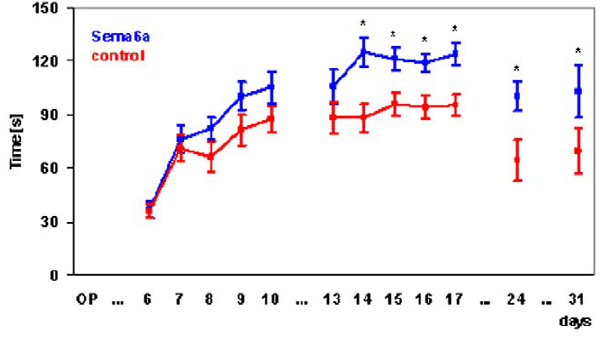
Figure 4. Effects of the cylinder test and adhesive tape removal test. (A) Cylinder test. (B) Adhesive removal task left. (C) Adhesive removal task left. The adhesive removal and cylinder tests were done both before (baseline) and 3, 20, and 34 days after ischemia. There was a strong trend towards better performance of the Sema6A AAV2 injected animals (blue line) in the cylinder test (repeated measures ANOVA, p=0.0752). Although the mean performance of Sema6A AAV2 injected rats in the adhesive tape removal appears better than control animals, this difference was not significant.